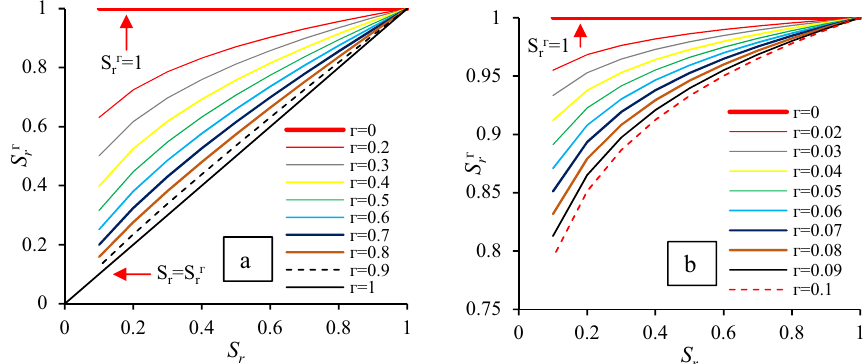
Fig. 2 S Ŵ r - S r relationships at different Ŵ values from ( a ) (0–1) and ( b )